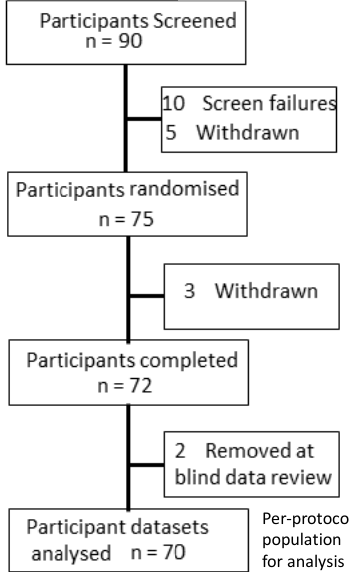
Figure 1. Participant disposition.